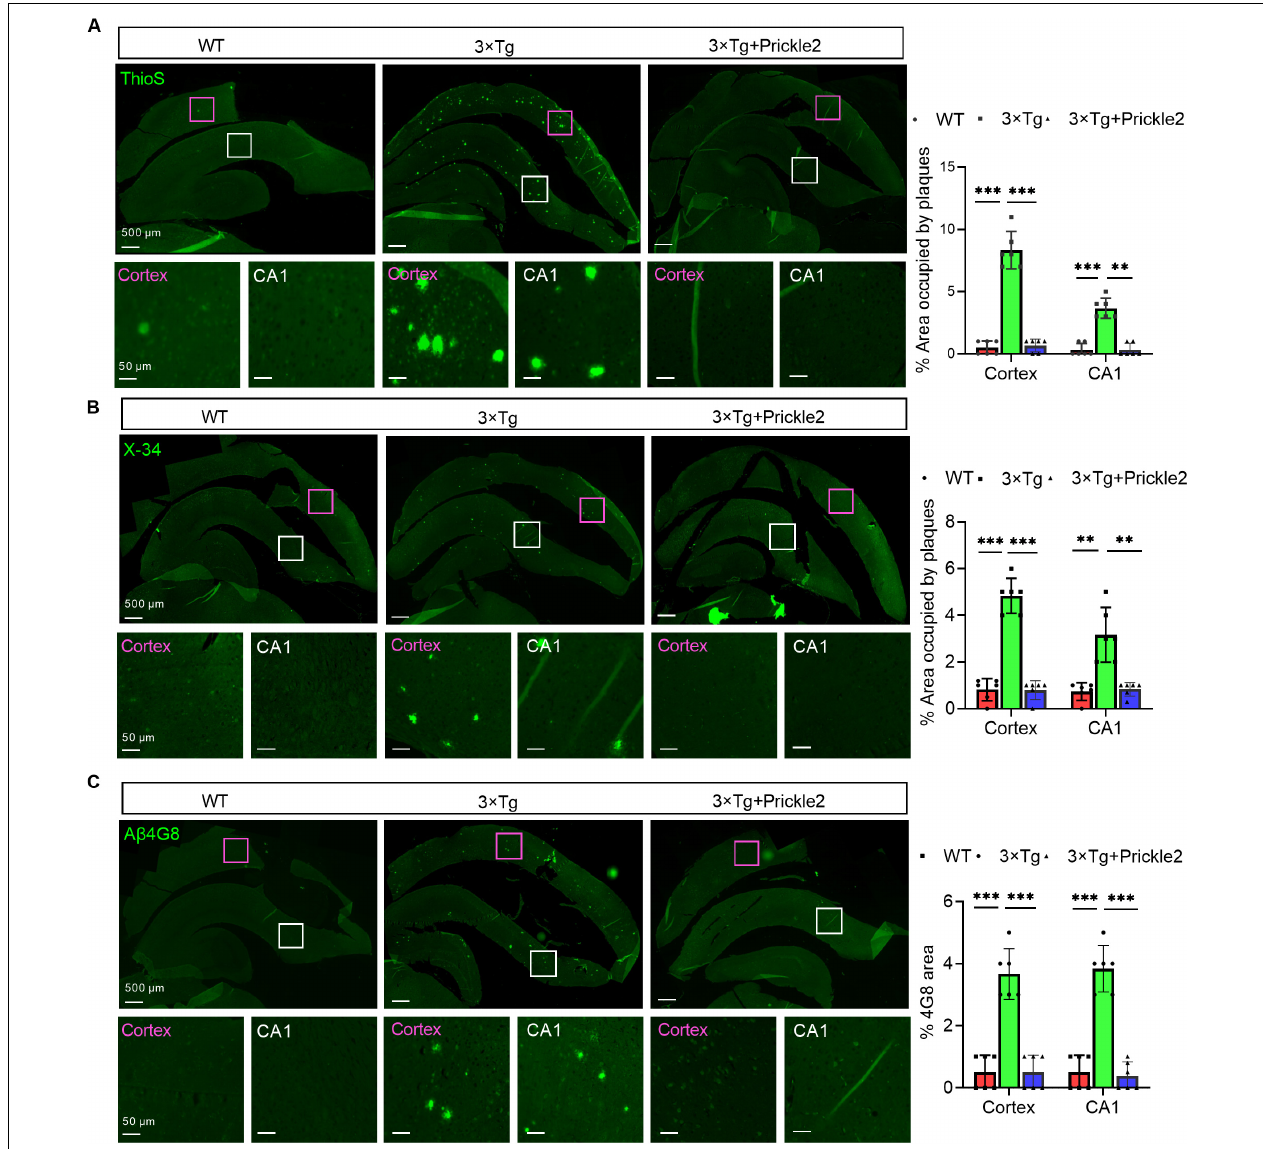
FIGURE 4 | Prickle2 treatment diminishes A β deposition and A β levels in 3 × TG mice. (A) Representative thioflavin S (ThioS, A β plaques) immunofluorescence images in cortex and hippocampus of WT, 3 × Tg and 3 × Tg/Prickle2 treatment mice. The percentage of cortical and hippocampal area occupied by A β plaques ( n = 6 per group). (B) Representative images of WT, 3 × Tg and 3 × Tg/ Prickle2 treatment mice stained with X-34 and the percentage of cortical and hippocampal area stained with X-34 was quantified ( n = 6 per group). (C) Representative immunofluorescence images stained by β -Amyloid 4G8 antibody. The percentage of cortical and hippocampal area stained with β -Amyloid 4G8 antibody was quantified ( n = 6 per group). ANOVA followed by Bonferroni’s post hoc test. ∗∗ p < 0.01; ∗∗∗ p < 0.001.